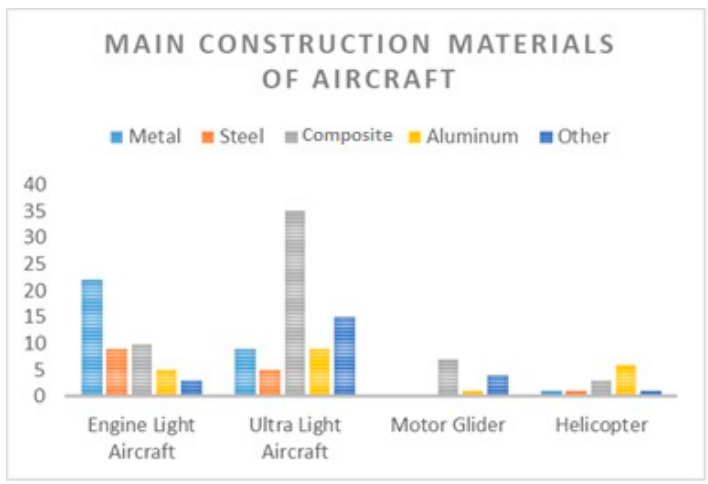
Figure 2. Construction materials of aircraft up to 2000 kg maximum take-off mass (MTOM).